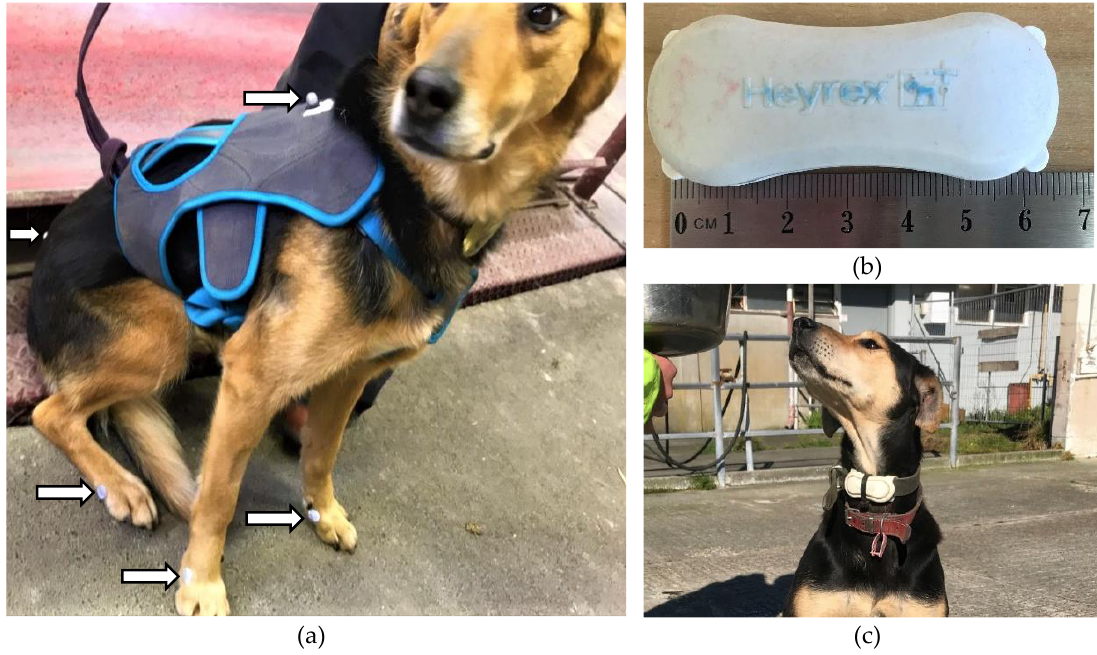
Figure 1. ( a ) indicates the placement of markers (white arrows) on each dog for motion capture of the dog as it moved on the treadmill, ( b ) is of the accelerometer used in this study, ( c ) is of the accelerometer on the dog, attached to the collar and positioned on the ventral side of the neck.